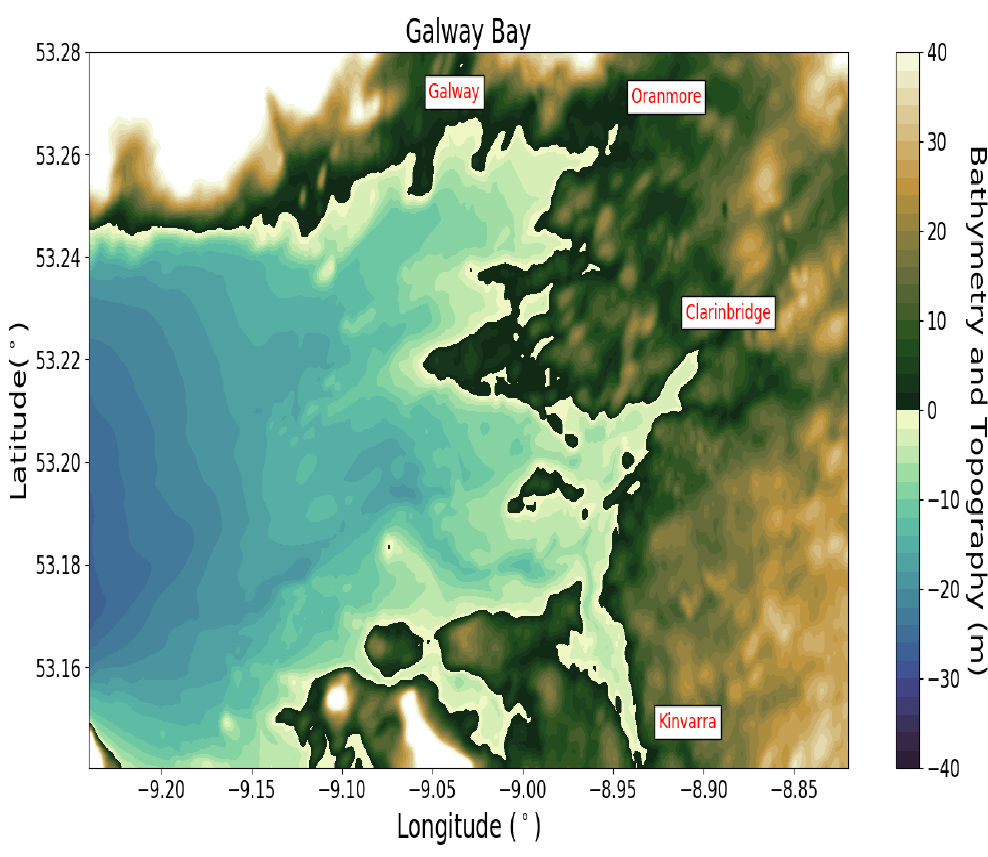
Figure 10. High resolution bathymetry and topography of Galway Bay, with key places